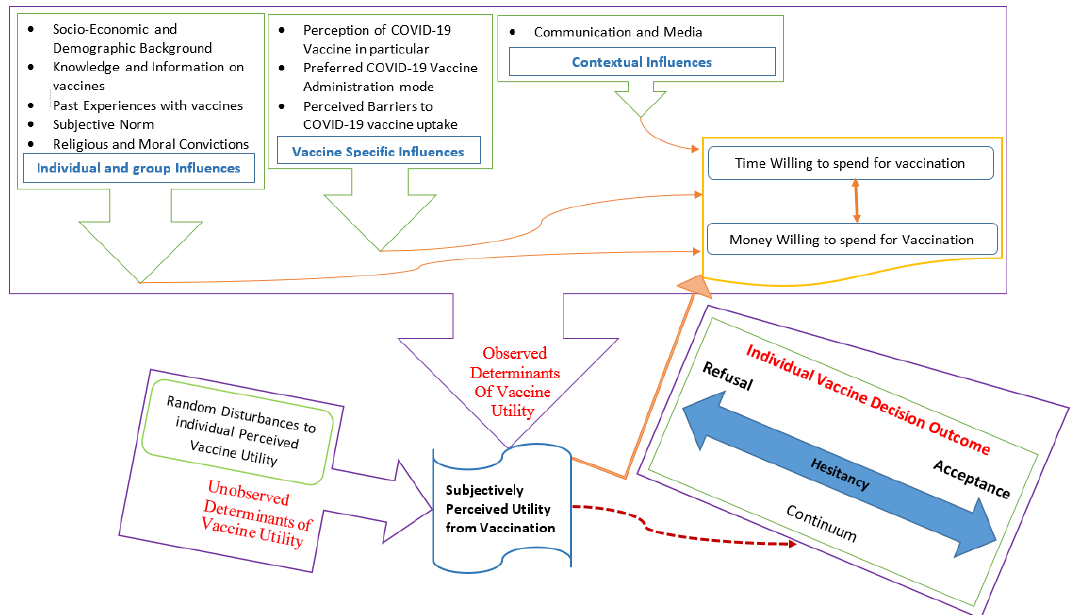
Figure 1. Random Utility Based Conceptual Framework for Individual’s COVID-19 vaccine decision-making. It is adapted from Figure 2 in